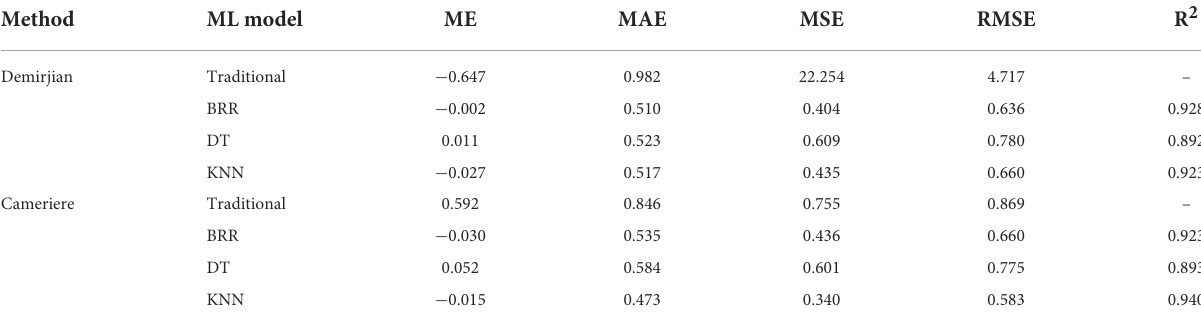
TABLE 2 Mean error (ME), mean absolute error (MAE), mean square error (MSE), root mean square error (RMSE), and R 2 values assessing performance of machine learning regression methods based on Demirjian and Cameriere method, respectively.